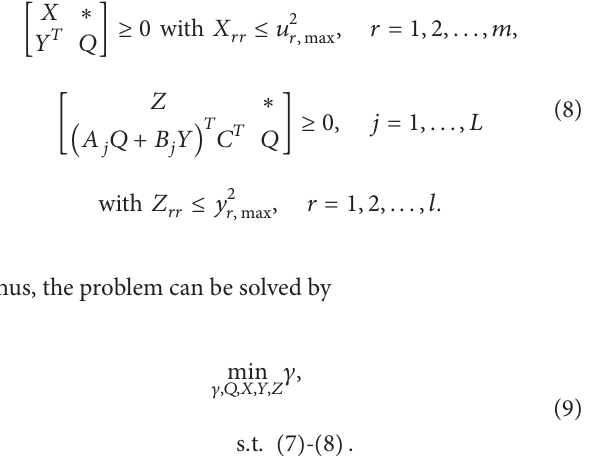
Algorithm 5 (automatic offline robust MPC). Consider